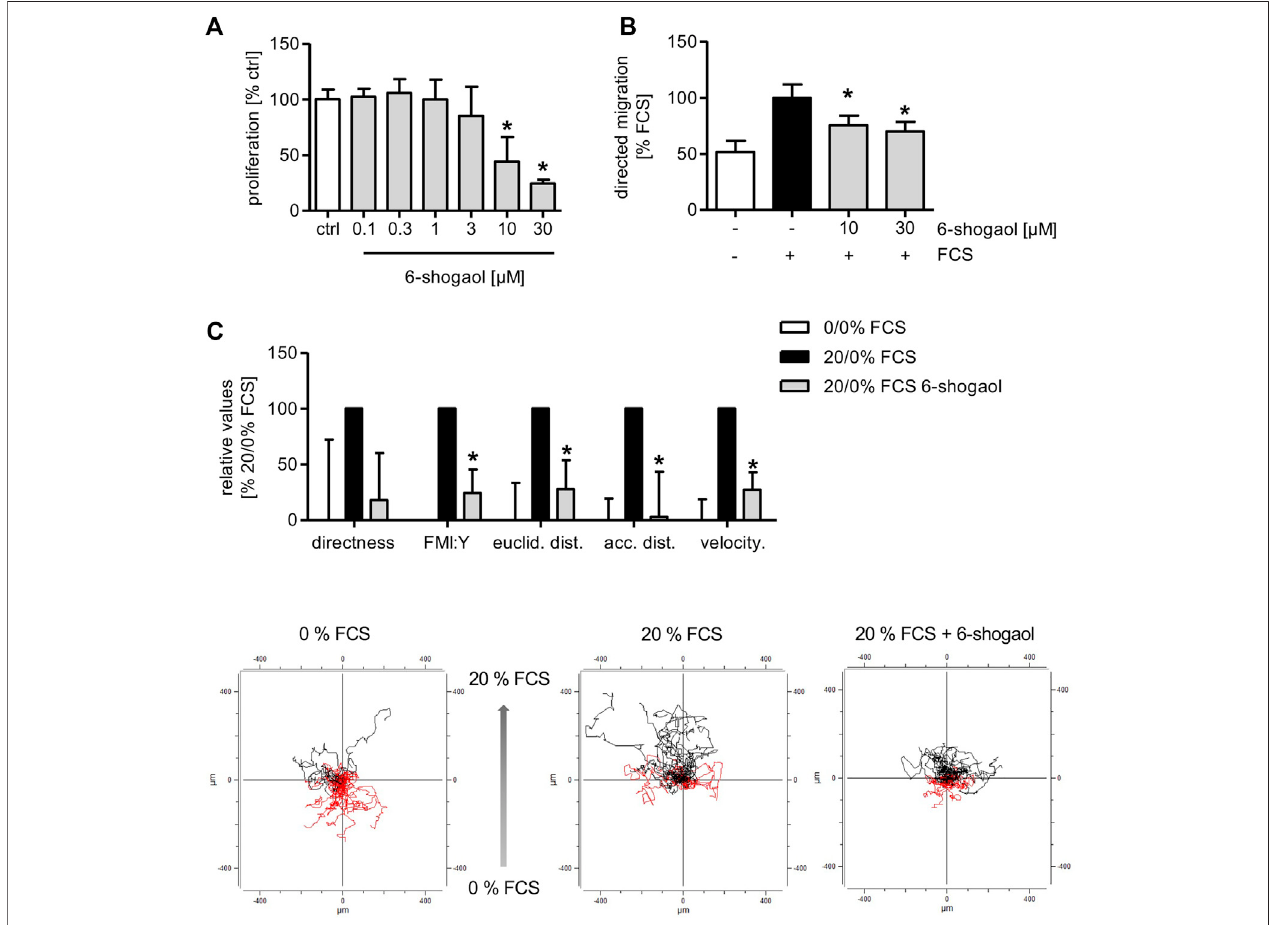
FIGURE 4 | 6-Shogaol reduces endothelial cell proliferation and migration. (A) 1,500 HUVECs per well were seeded on collagen-G-coated 96-well plates. 24 h later, the cells were treated with 6-shogaol at the indicated concentrations for 72 h. Subsequently, the cells were stained using crystal violet. DNA-bound crystal violet was leached using acetic acid (20%), and absorbance of the dye was measured in a plate reader at 590 nm. (B) 100,000 HUVECs were seeded onto Transwell inserts. Subsequently, the cells were treated with indicated concentrations of 6-shogaol, and a serum gradient was generated by the addition of 20% FCS to the lower chamber. The cells were allowed to migrate toward the FCS gradient for 16 h. (C) 18,000 HUVECs were seeded on chemotaxis slides, treated with 6-shogaol (30 µM), andallowedtomigrateinthedirectionofaserum(20%)gradientfor20 h.Usingphase-contrastmicroscopy,imagesweretakenevery10 min,and30cellspercondition were analyzed using ImageJ. Data are expressed as mean ± SD; (A – C) n = 3; (A) * p ≤ 0.05 vs. ctrl; (B,C) * p ≤ 0.05 vs. FCS